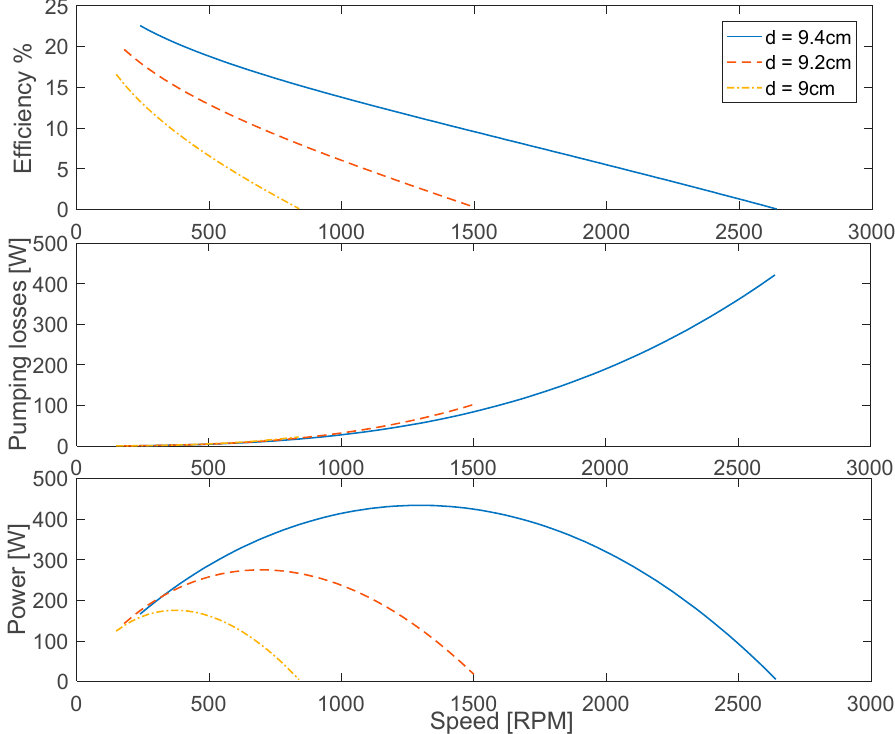
Figure 8. Influence of increasing the isothermal fins diameter on the Franchot engine performance for doubled Franchot engine cylinder diameter D e = D c = 10 cm.